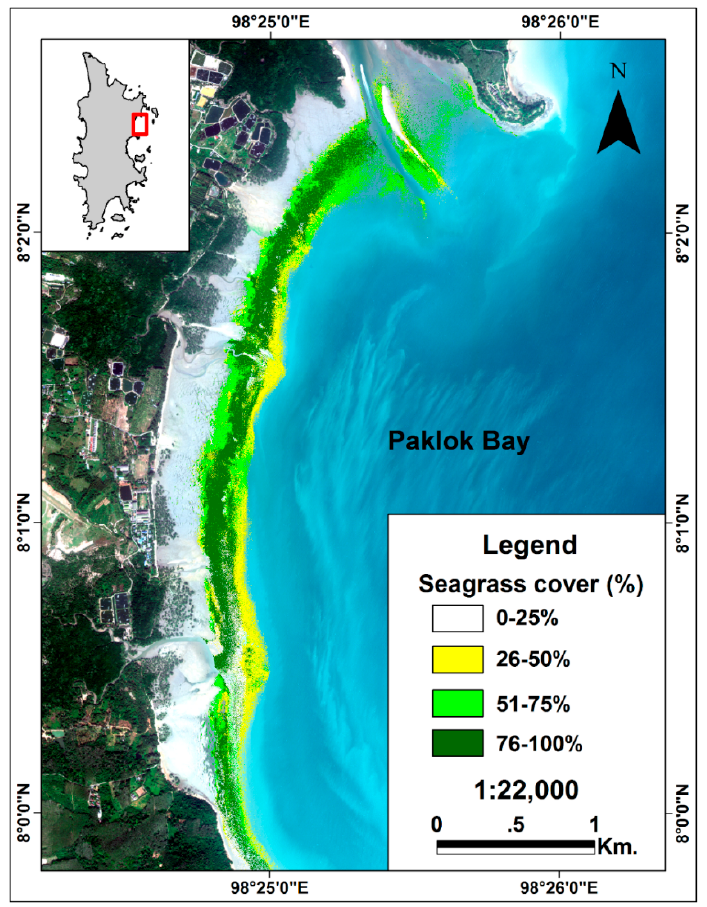
Table 5. The confusion matrix and summary error statistics for seagrass cover mapped from the Worldview-2 image validated against the reference field data of seagrass percentage cover estimated from photo transects. PA is Producer’s accuracy; UA is User’s.